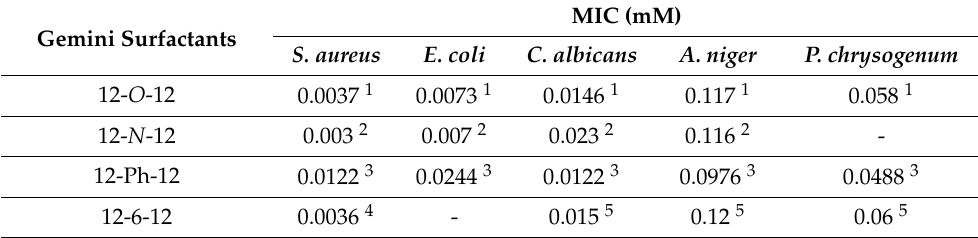
Figure 4. Chemical structure of GS with different spacer nature. Table 5. MIC values (mM) of gemini surfactants with different spacer nature.